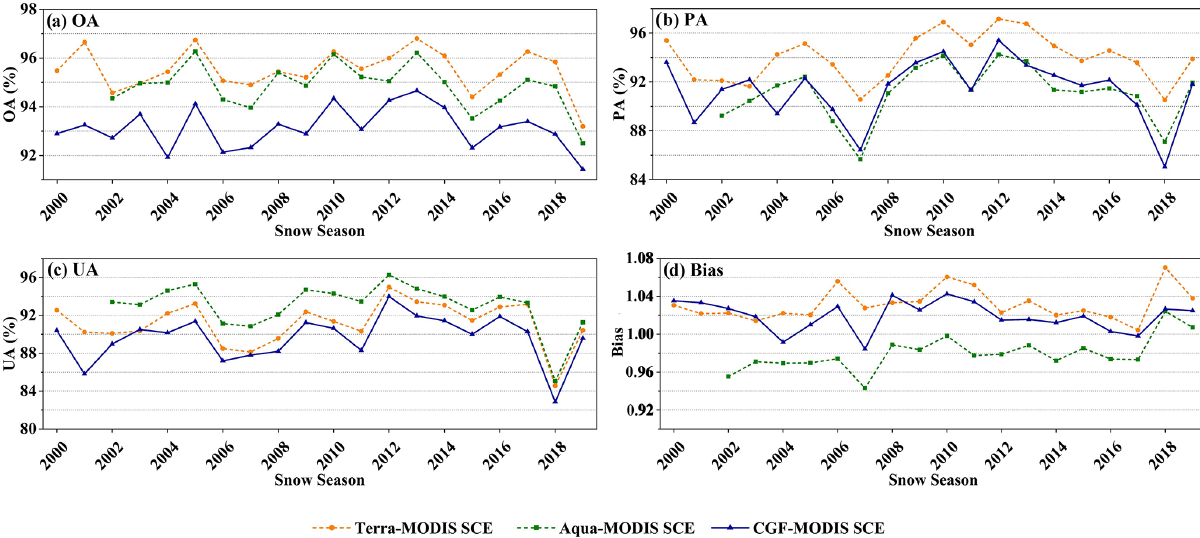
Figure 8. Annual accuracy metrics’ fluctuation of the NIEER MODIS SCE product: (a) OA, (b) PA, (c) UA, and (d) Bias.